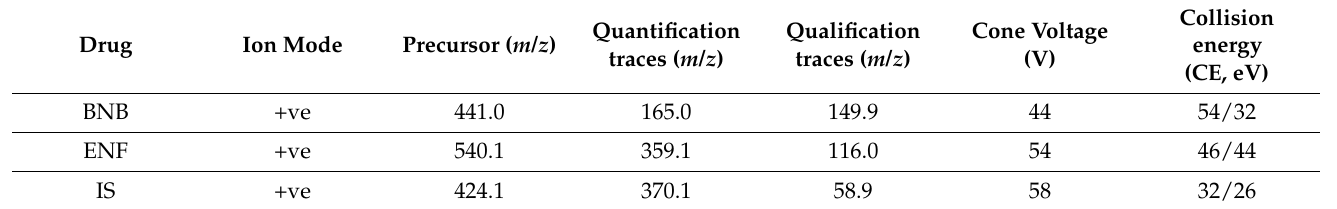
Table 1. LC-MS/MS optimized parameters for the determination of encorafenib, binimetinib and IS.